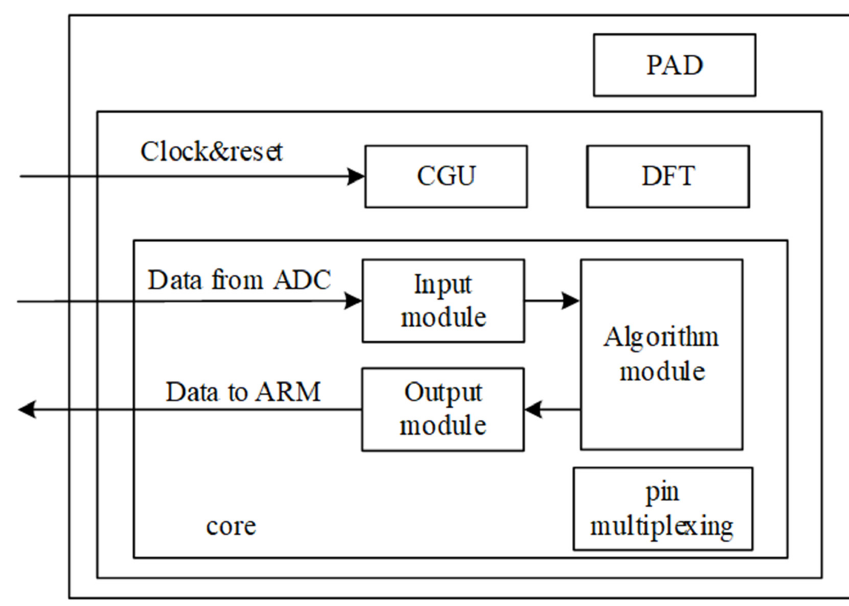
Figure 4. Hardware level of the spectrum processing module.